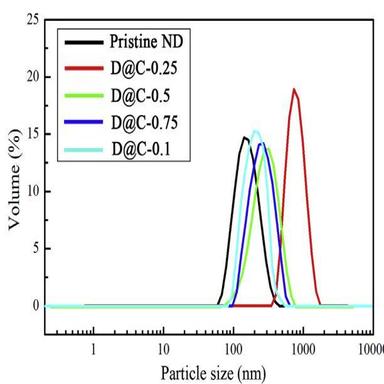
Particle size distribution of the pristine ND and D@C-x composites in the polishing slurry (pH 8.6).